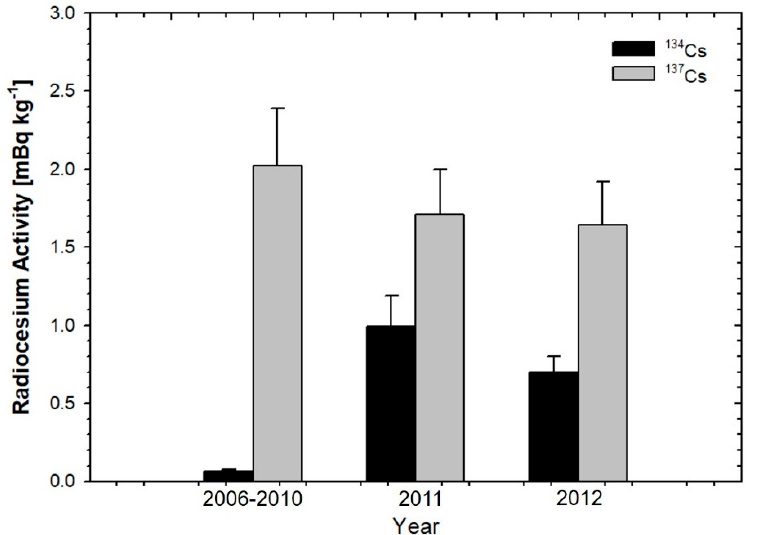
Figure 3. The comparisons of the annual mean activities of 134 Cs and 137 Cs in the Korean seas from 2006 to 2012. All the data were applied from the national report of Korea Institute of Nuclear Safety (KINS) [45]. We note that the data from 2011 and 2012 are in the same 22 locations, but the data before 2010 were only for eight stations per year before the expansion of the monitoring region due to the Fukushima accident.